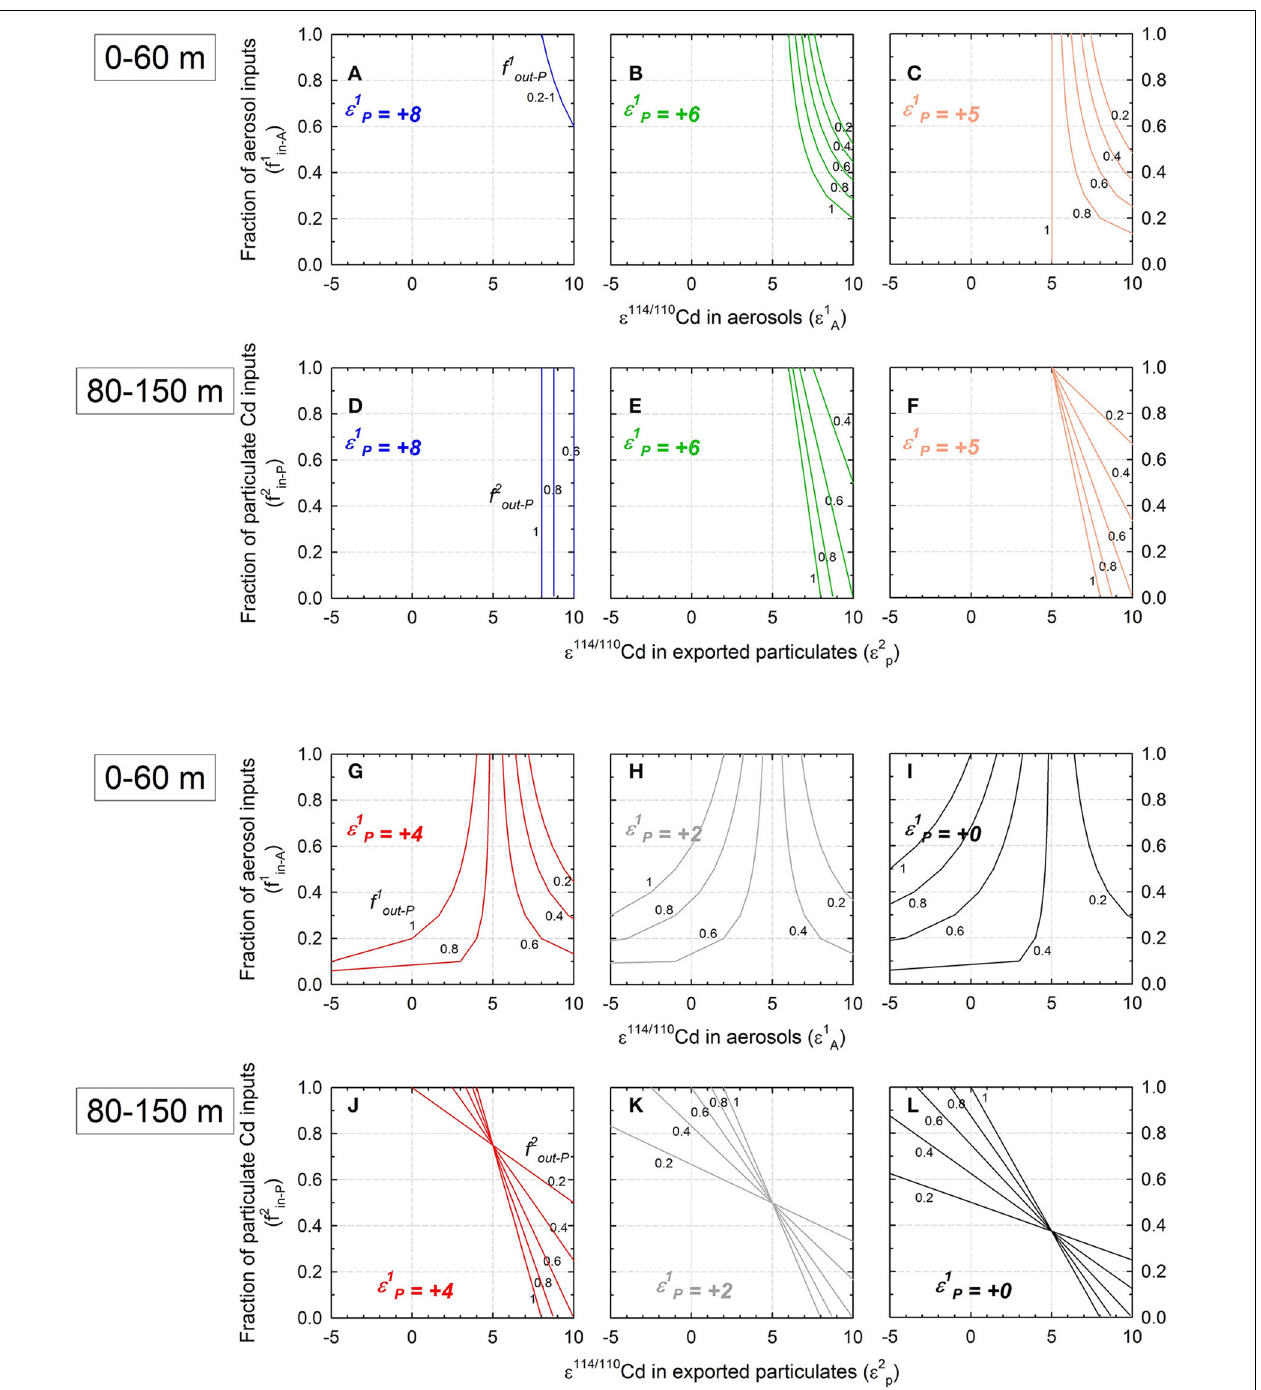
set from + 8 to + 0 ε . The fractions of Cd exported through particle sinking FIGURE 8 | Modeled relationship between the isotopic composition in in the 0–60m and 80–150m boxes ( f 1 out − P and f 2 out − P , respectively) are ) and the fraction of aerosol inputs ( f 1 ) in the 0–60m aerosols ( ε 1 A in − A box and relationship between the isotopic composition in exported both set from 0.2 to 1 (the numbers in black in the diagrams). The ) and the fraction of particulate Cd inputs ( f 2 ) in particulate Cd ( ε 2 model results of (A–F) ( ε 1 P is set as + 8 to + 6) are unrealistic because P in − P the 80–150m box. (A–C) and (G–I) , the relations of ε 1 A and f 1 in − A in the the calculated ε 2 P is all heavier than + 5 ε (the composition of the Cd 0–60m box; (D–F) and (J–L) , the relations of ε 2 P and f 2 in − P in the inventory of the 80–150m box), indicating that phytoplankton prefer to 80–150m box. The isotopic composition of exported particulate Cd ( ε 1 P ) is take up relatively heavy Cd isotopes from